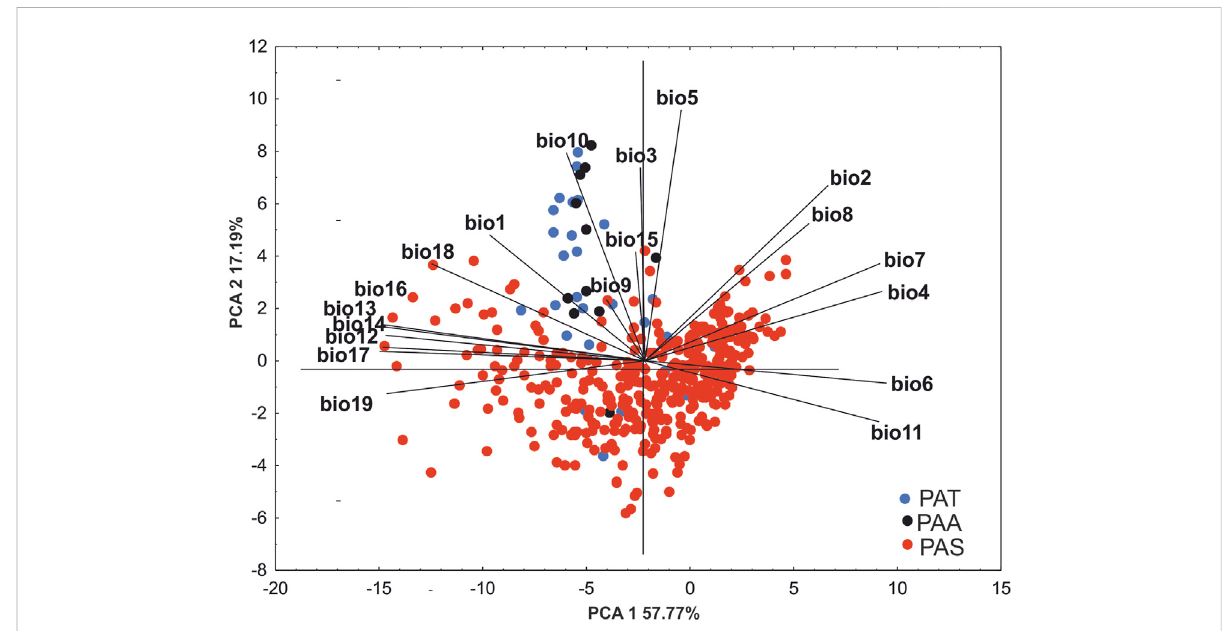
FIGURE 2 PCA ordination diagram (principal component analysis) of the distributions of populations of P. albida ssp. straminea (red dots), P. albida ssp. albida (black dots), and P. albida ssp. tricuspis (blue dots) based on 19 bioclimatic